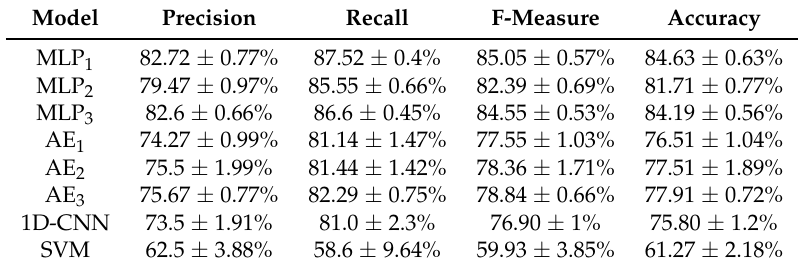
Table 1. Comparative results of the proposed MLP, AE, 1D-CNN, SVM classifiers evaluated on the test sets. All the outcomes are reported as mean value ± standard